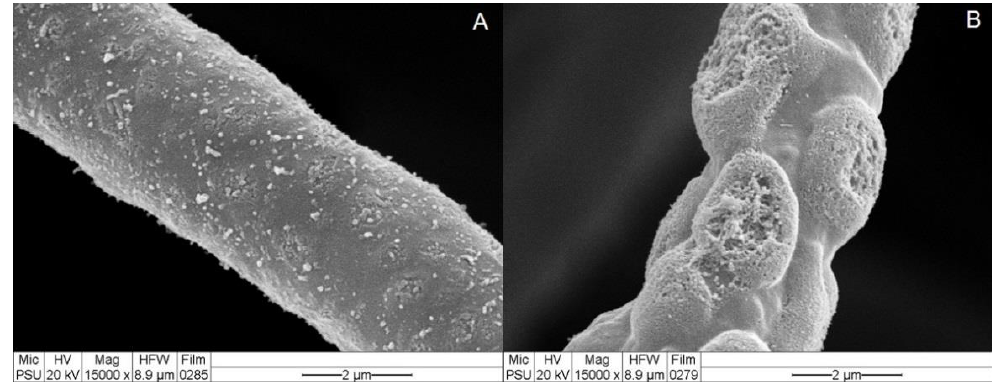
Figure 4. Effects of cell-wall-degrading enzymes on the fungal morphology of C . gloeosporioides ( A ) hypha of C . gloeosporioides incubated in potato dextrose broth alone; ( B ) hypha of C . gloeosporioides incubated in cell-free culture filtrate (CF) of T. koningiopsis PSU3-2.